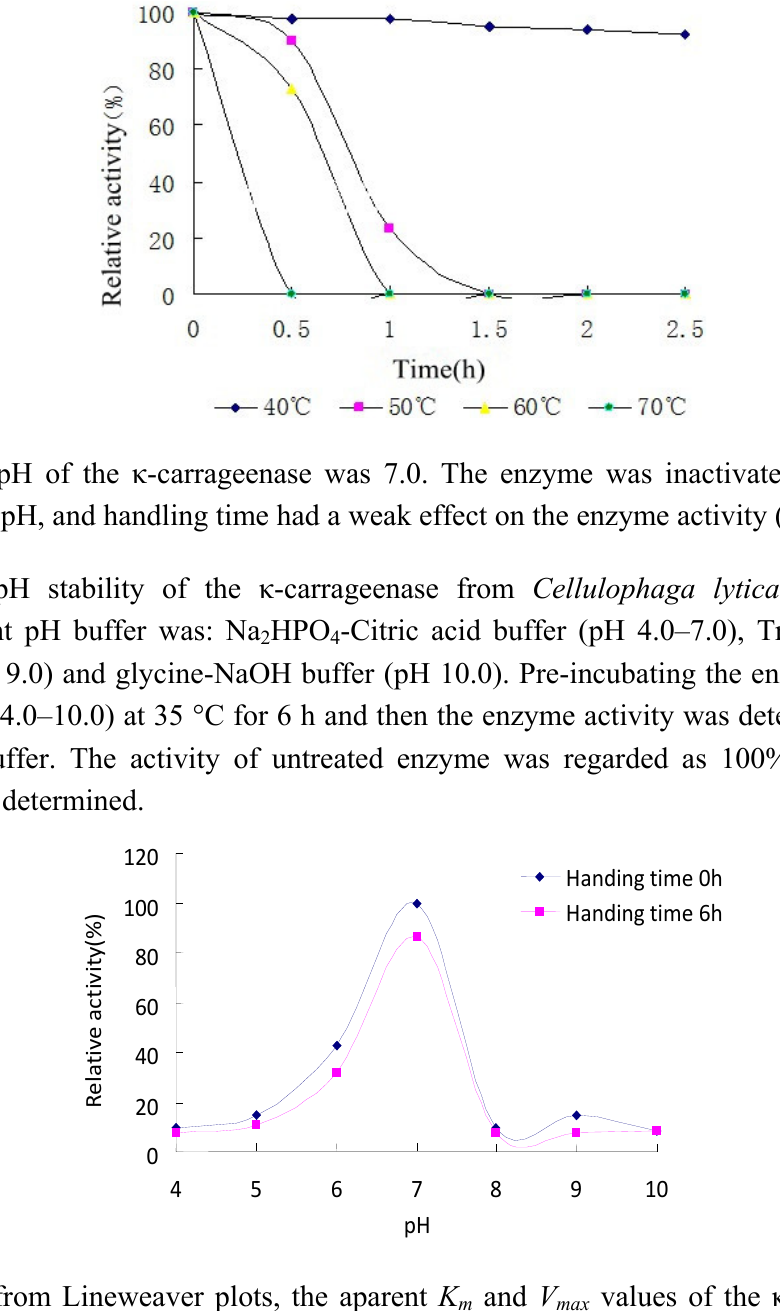
Figure 4. Temperature stability of the κ-carrageenase from Cellulophaga lytica strain N5-2. The enzyme solution was incubated at each temperature (20–70 °C) for 0.5 to 2.5 h and then the residual enzyme activity was measured. The activity of untreated enzyme was regarded as 100% and relative activity was determined.